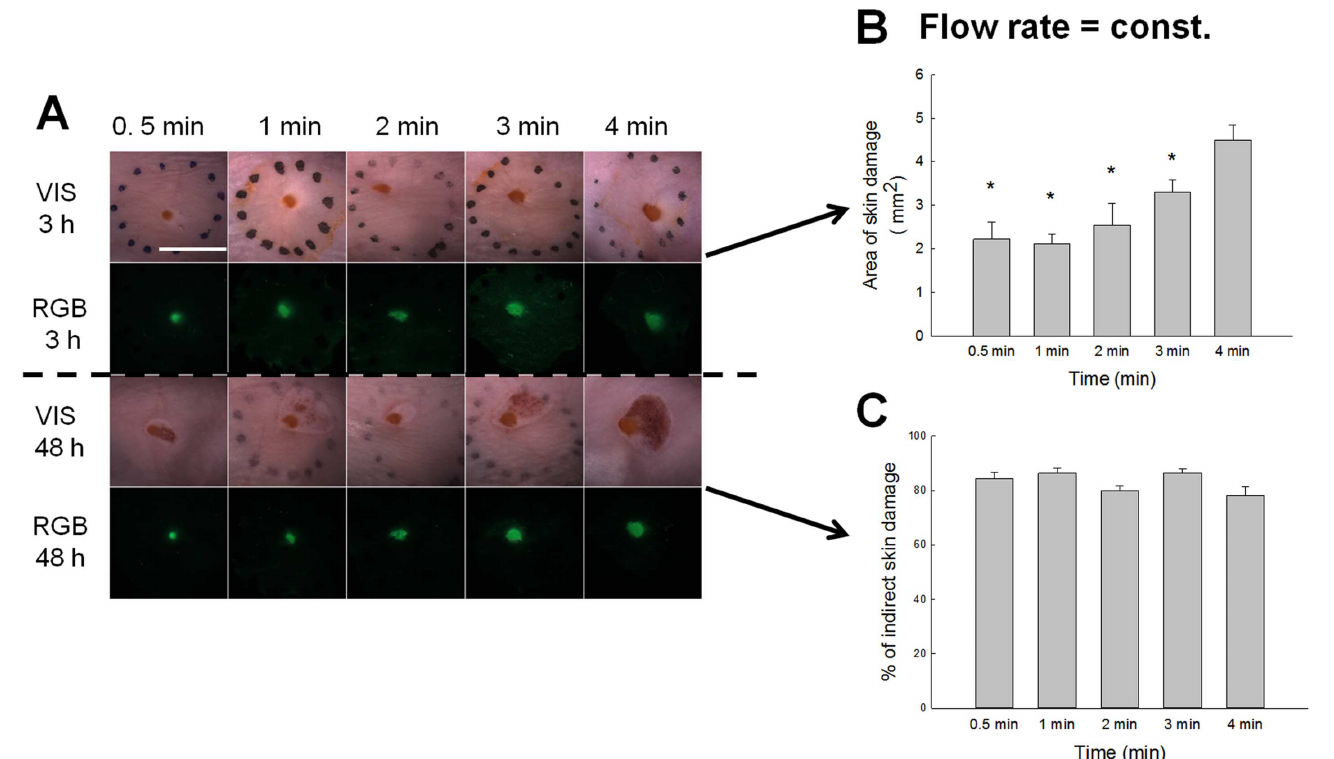
Fig 2. Skin damage observed under different treatmenttimes at constant gas flow rate of 5 L/min. A) Representative imagesof the skin damage in the treated region.Treated skin regionswere observedunder stereomicroscope. Imageswere taken under visiblelight (VIS) and the fluorescence was observedunder RGB (red, green, blue)parameters. Scale bar: 5 mm. B) The area of the direct skin damagewas measured3 h post-treatment and statistically evaluatedfrom RGB images.Error bars indicateSEM. * P value < 0.05 betweenthe selectedgroup and the group exposedto the longest treatment time (treated 4 min under 5 L/min). C) Percentage of indirectskin damagequantifiedfrom the total damage (direct andindirect), measured48 h post-treatment. Damagewas statistically evaluated from RGB image. Error bars indicateSEM.